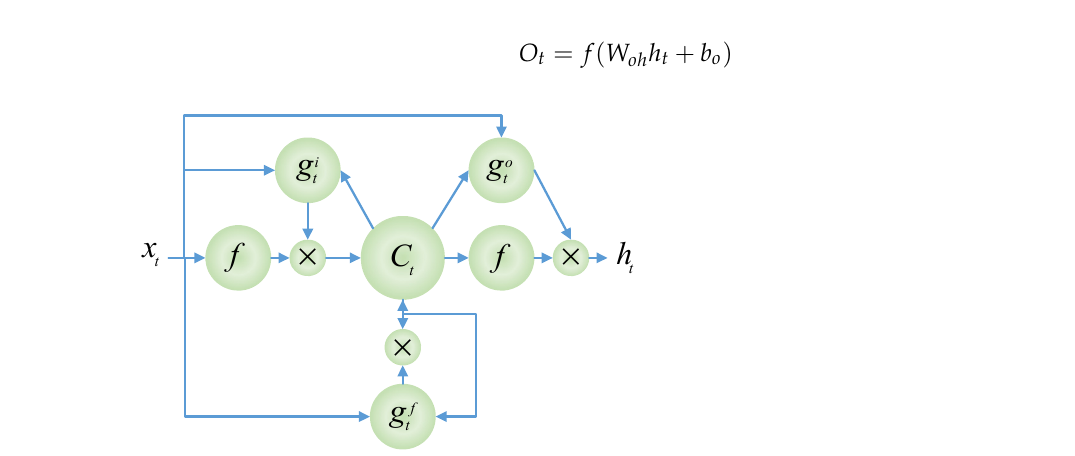
Figure 5. Schematic diagram of the LSTM hidden state calculation.